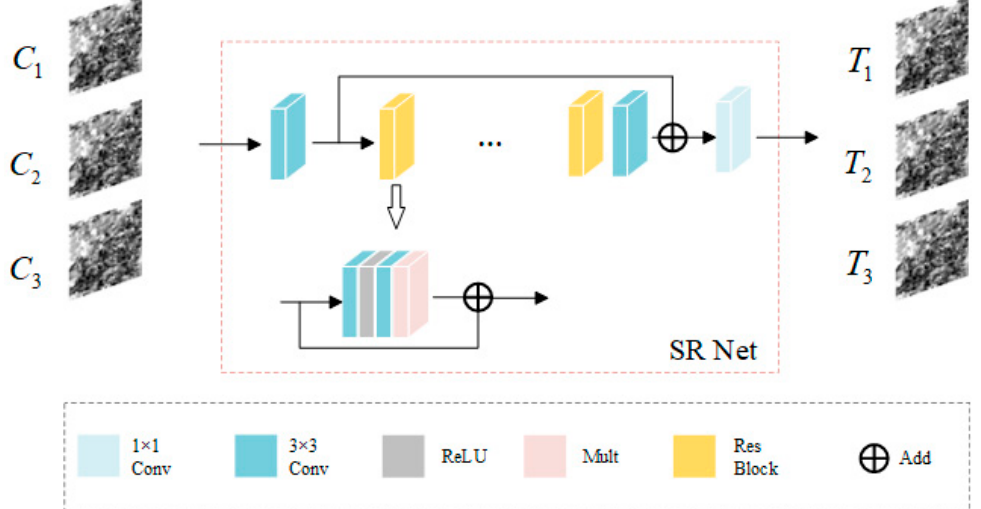
Figure 2. SR Net architecture. The coarse images ( (cid:1829) (cid:3036) ) at three times are, respectively, input into SR Net for pixel enhancement and the transition images ( (cid:1846) (cid:3036) ) are